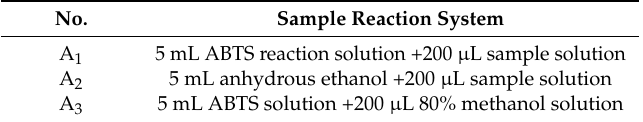
Table 2. ABTS + (2,2’-azino-bis(3-ethylbenzthiazoline) 6-sulphonic acid) determination.